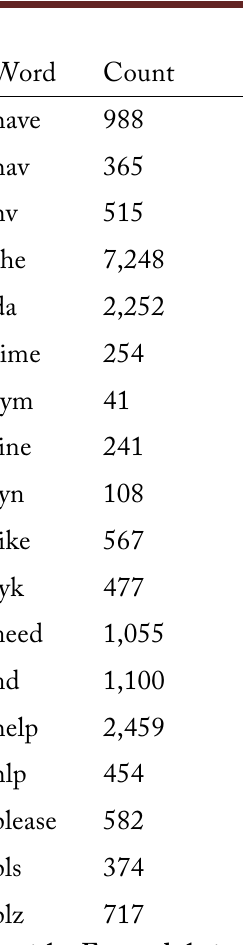
Table 2: Common words with <E>s and their alternate spellings The Letter